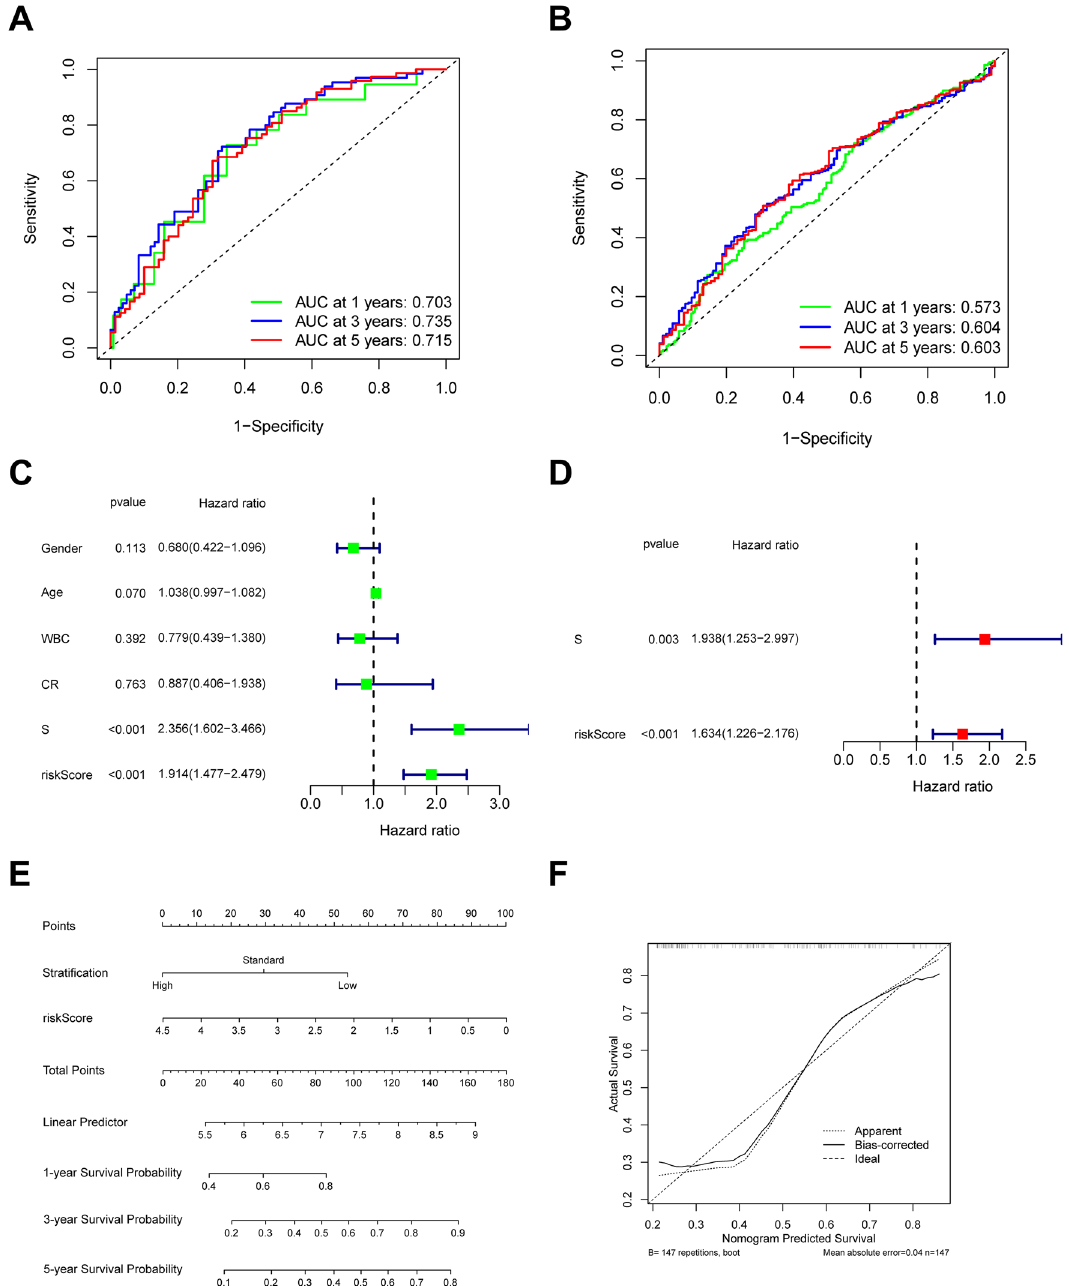
Figure 4. Efficiency of the hypoxia risk signature in prognostic prediction in AML. ( A , B ) ROC curves which showed the hypoxia risk signature’s predictive efficiency on the survival rate in AML from TARGET and GEO databases; ( C , D ) Univariate and multivariate Cox analyses which evaluated the risk signature’s independence in prognostic value in terms of overall survival in pediatric AML patients; ( E ) Nomograms for the probability of death at 1-, 3- and 5-years; ( F ) The calibration curve of the